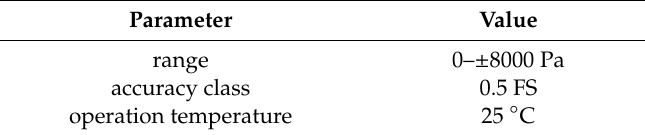
Figure 11. Experimental scheme: ( a ) experimental test principle; ( b ) experimental arrangement. The working parameters of the micromanometer are shown in Table 3. Table 3. Working parameters of the micromanometer.